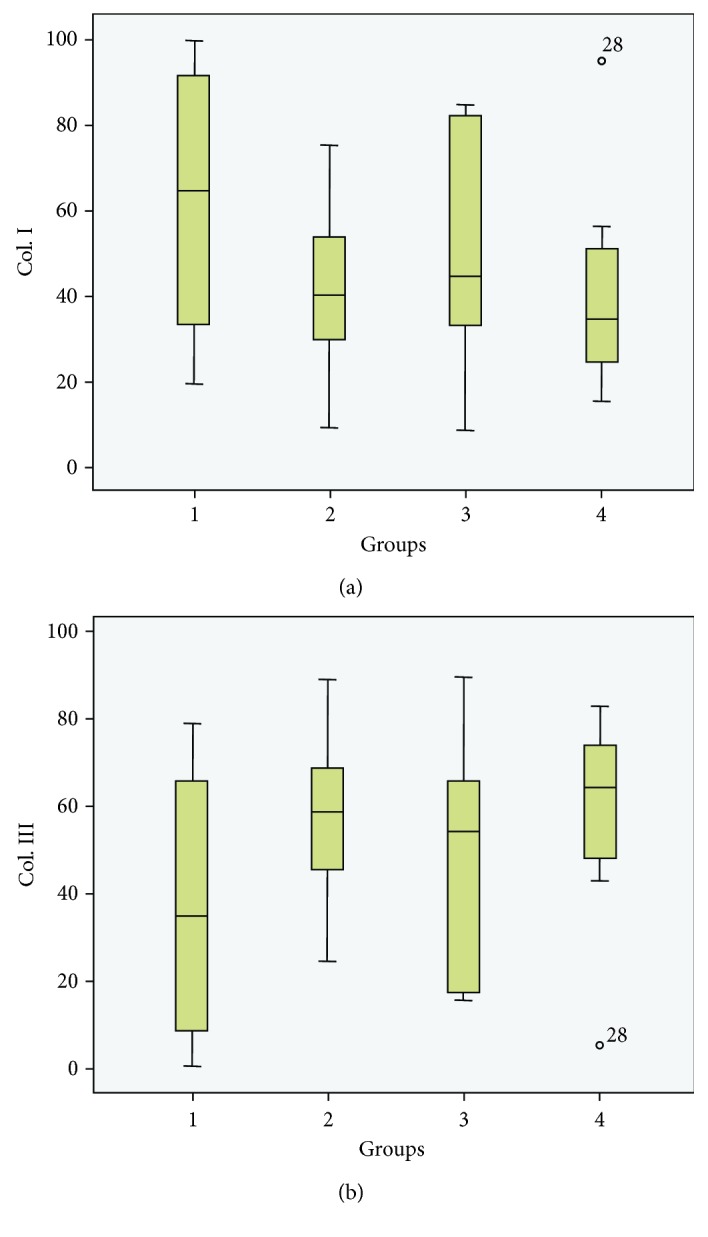
Histograms of the proportions of collagen (types I or III) in each group.